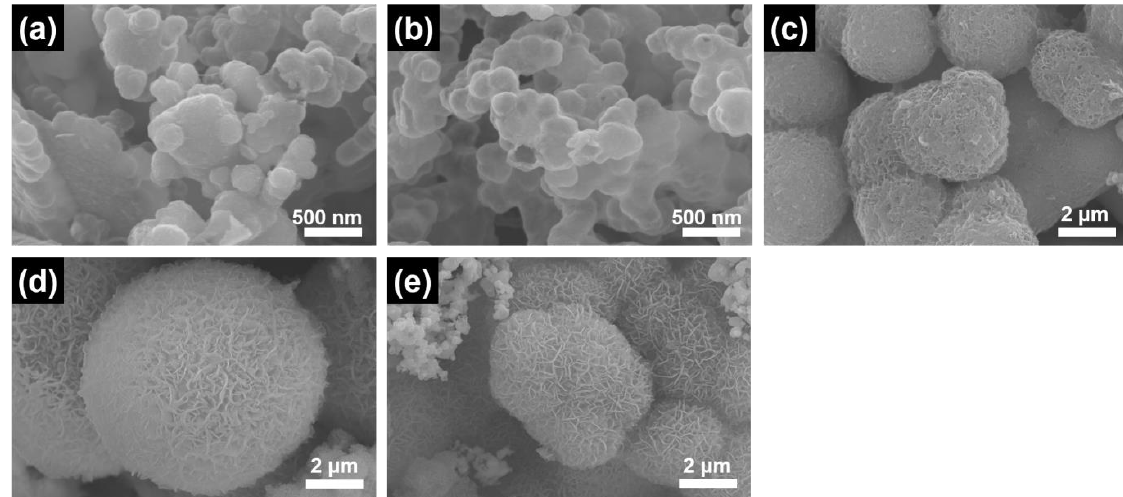
Figure 3. SEM images of Ni nanoparticles synthesized at 120 °C with different concentration ratios of Ni:AB: ( a ), 1:0.1, ( b ) 1:0.2, ( c ) 1:1, ( d ) 1:2, and ( e ) 1:4, respectively.